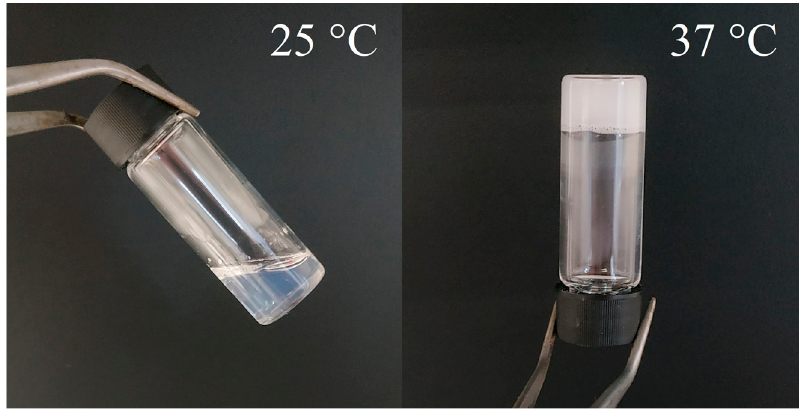
Figure 4. PCLA hydrogel (25 wt.%) behavior at 25 °C and 37 °C.